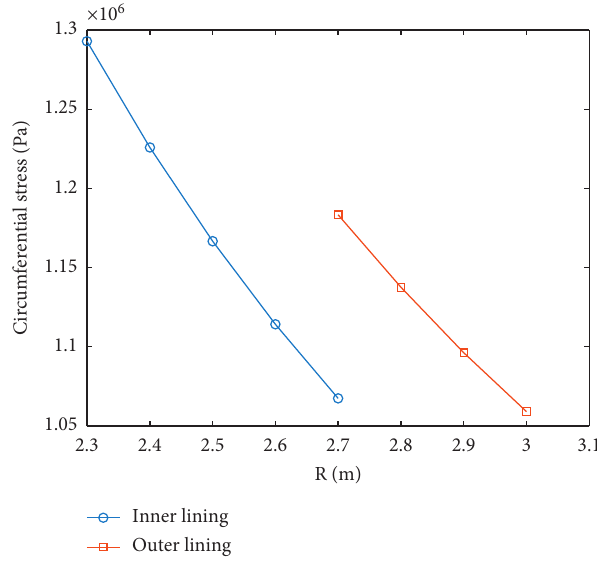
Figure 6: Distribution of circumferential stress under internal